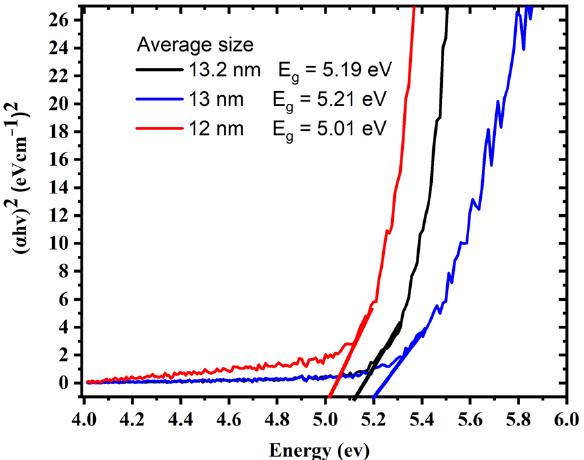
Figure 5. Tauc’s plot extrapolation to determine the bandgap of AgNP colloids for different ablation times.